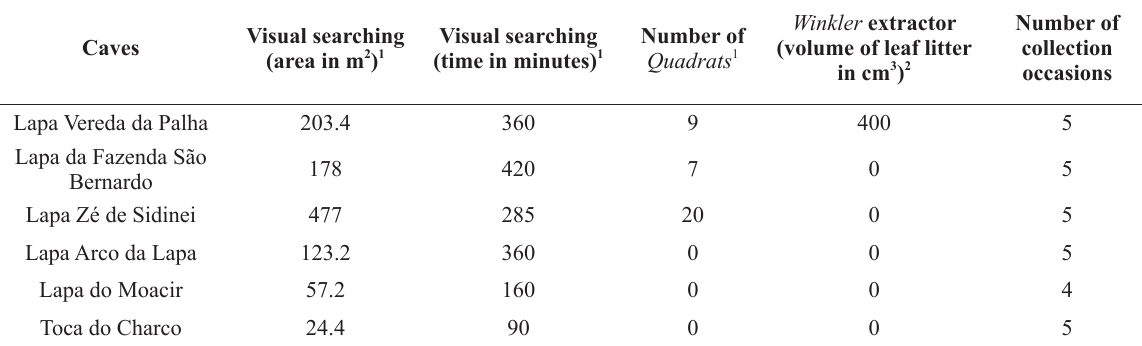
Collection method and effort for sampling of invertebrates in the Presidente Olegário caves, Minas Gerais, Brazil. Caves